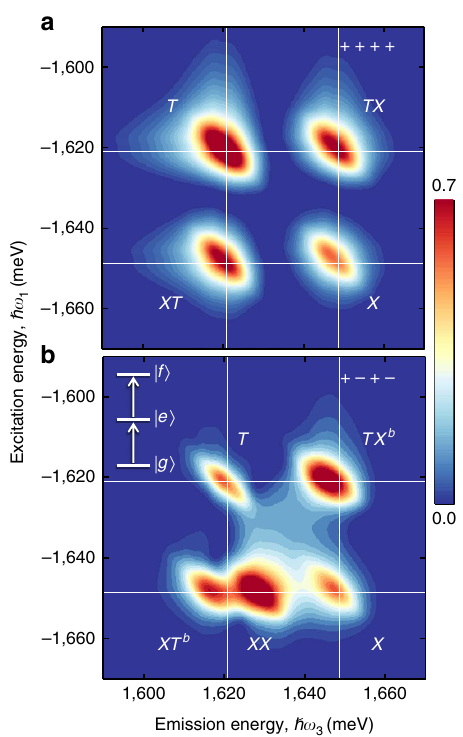
Figure 4 | Calculated 2D spectra incorporating the singly- and doubly excited-state manifold. Normalized 2D amplitude spectrum for ( a ) co- circular and ( b ) cross-circular polarization of the excitation pulses and detected signal. In the case of cross-circular polarization, both the singly and doubly excited states indicated by the inset are accessible.